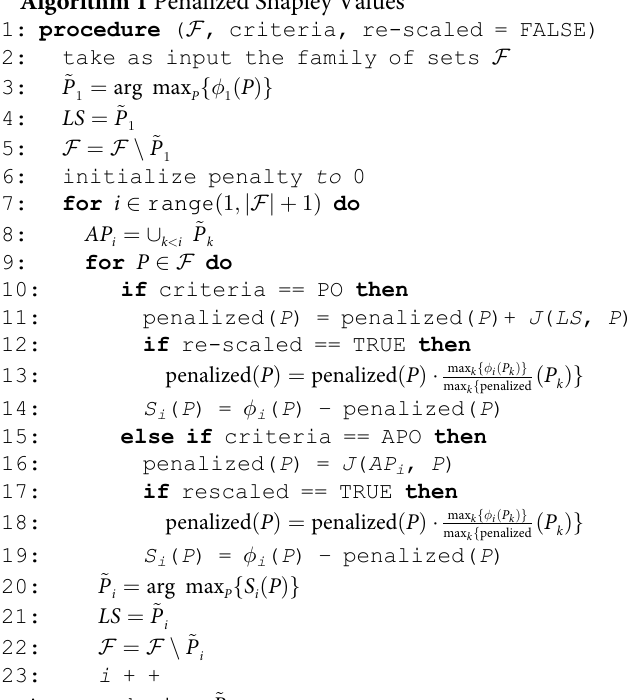
Algorithm 1 Penalized Shapley